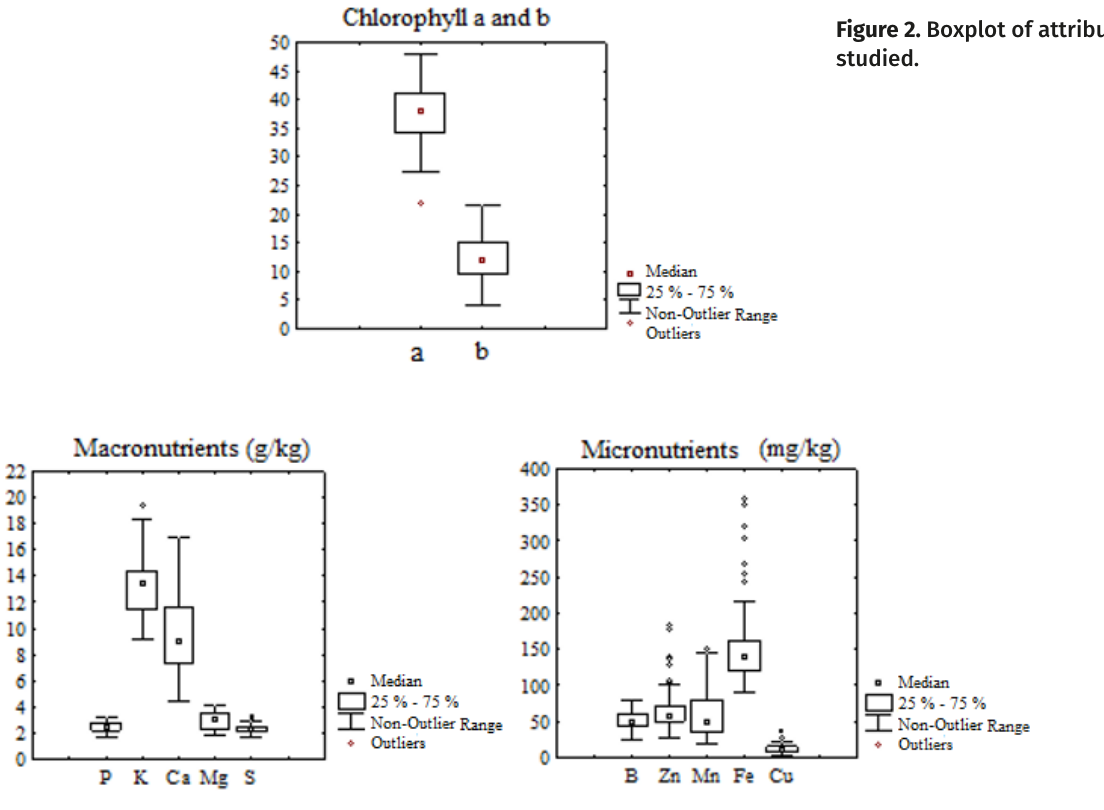
Figure 2. Boxplot of attributes